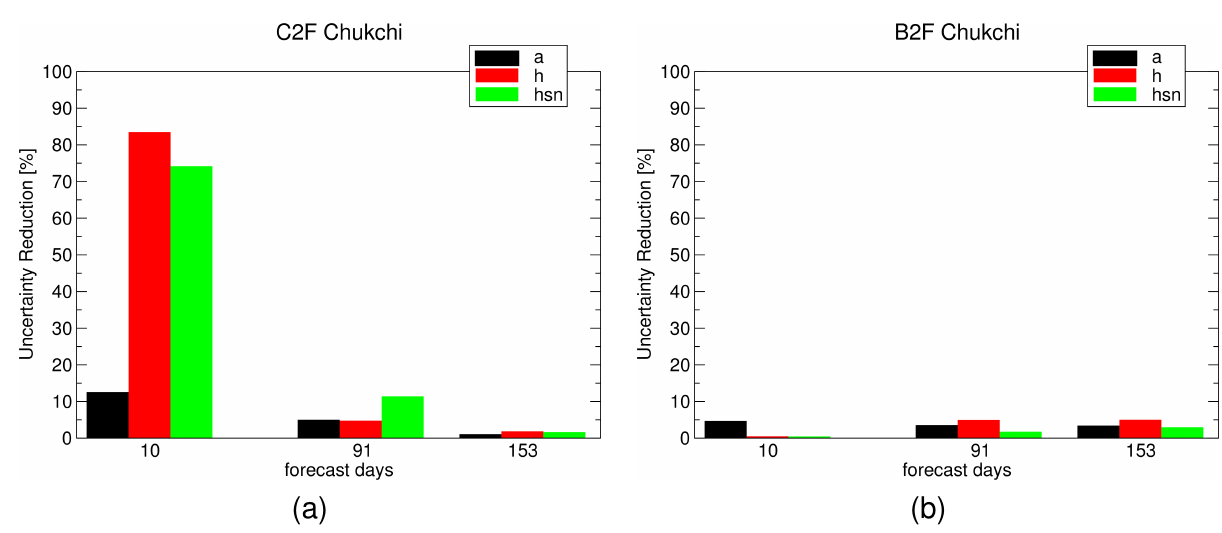
Figure 3. Uncertainty reduction for the Chukchi target area for flight transect C2F (panel a ) and B2F (panel b ) for target quantities mean ice concentration a , mean ice thickness h and mean snow depth hsn.